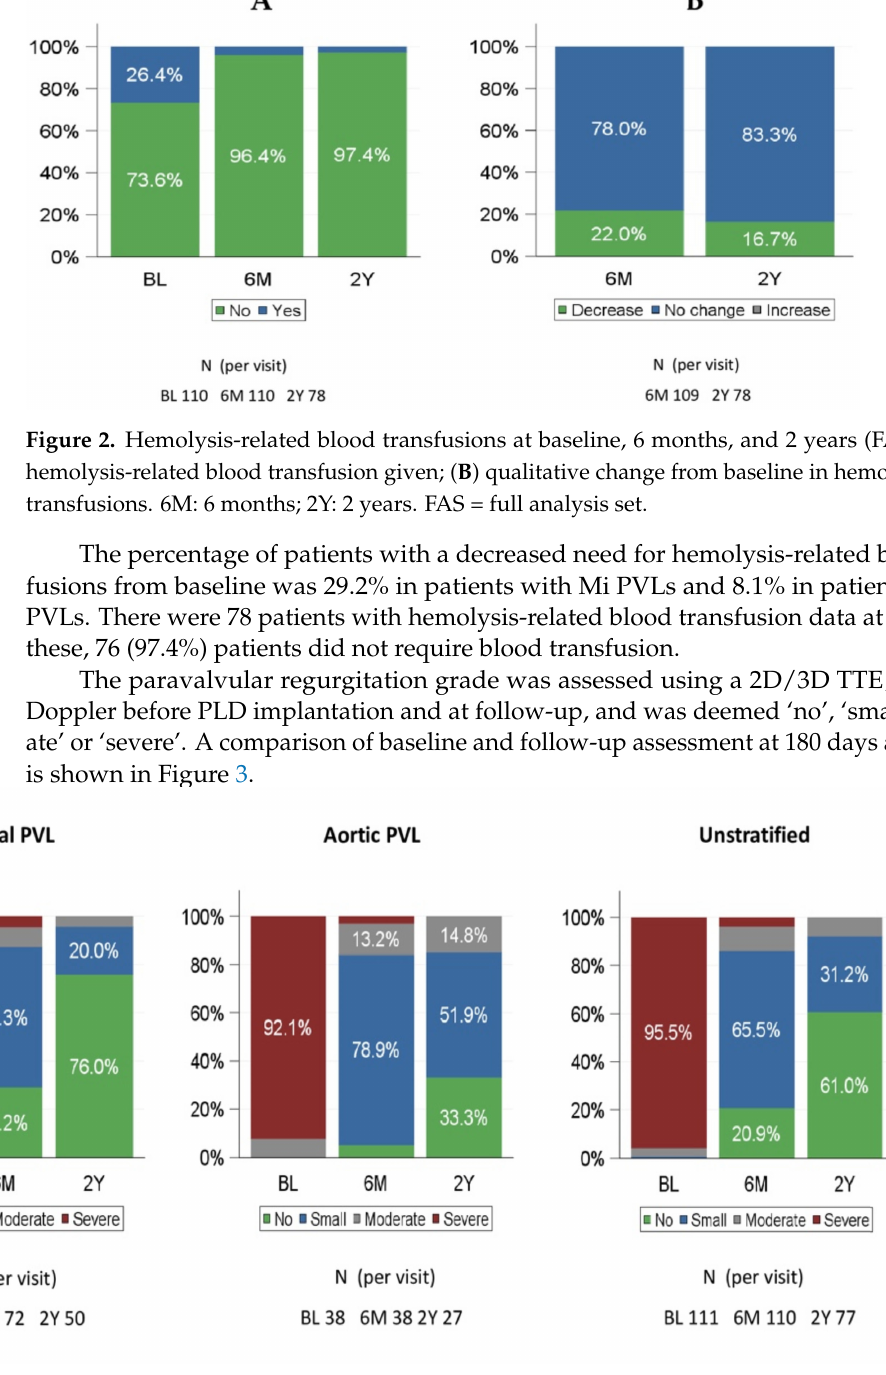
Figure 3. Paravalvular regurgitation grade at baseline, 6 months and 2 years (FAS). BL: baseline, 6M: 6 months; 2Y: 2 years. PVL = paravalvular leak. FAS = full analysis